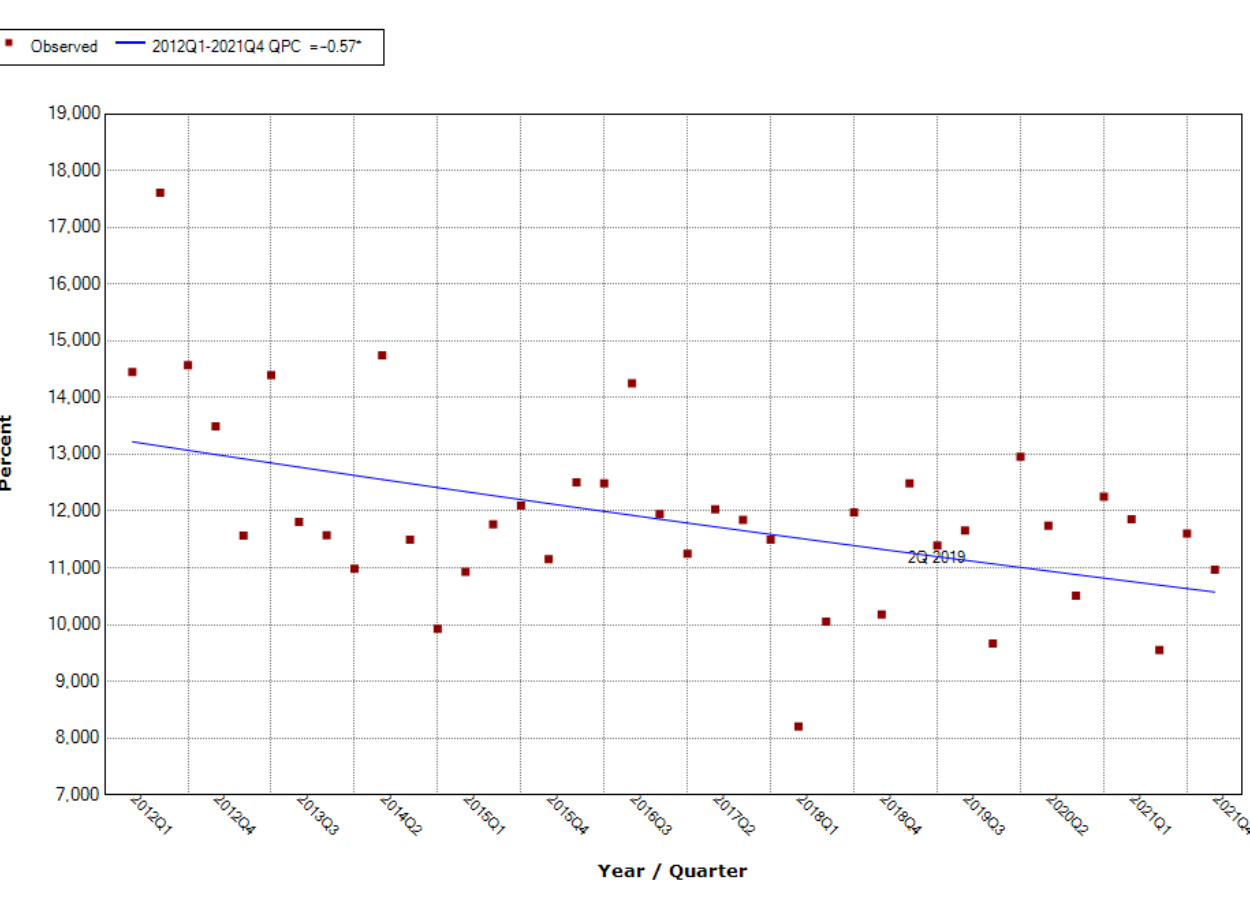
Figure A12. Percentage of products containing niacin in individual quarters in the period from 2012 to 28 November 2021. Joinpoints mark trend turning points. The date above the observation indicates the moment of publication of the scientific opinion/resolution.